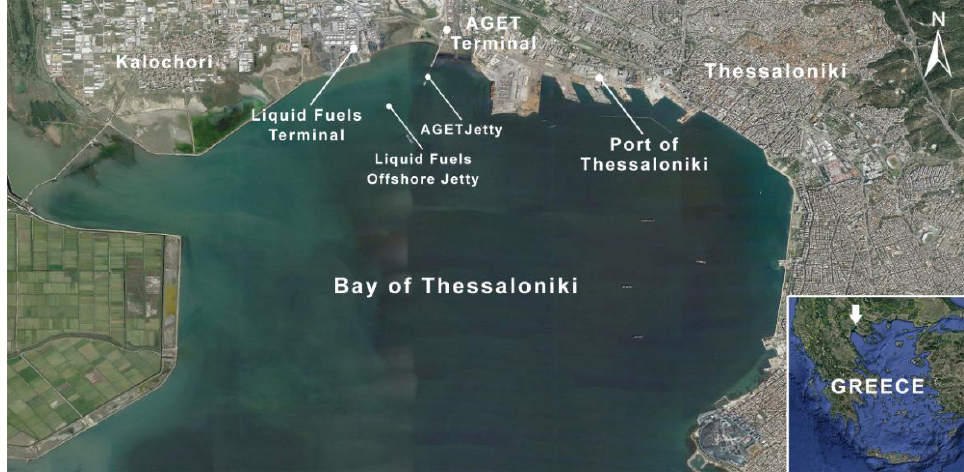
Figure 5. Geographic location and satellite image of the study area ([68]; privately processed).